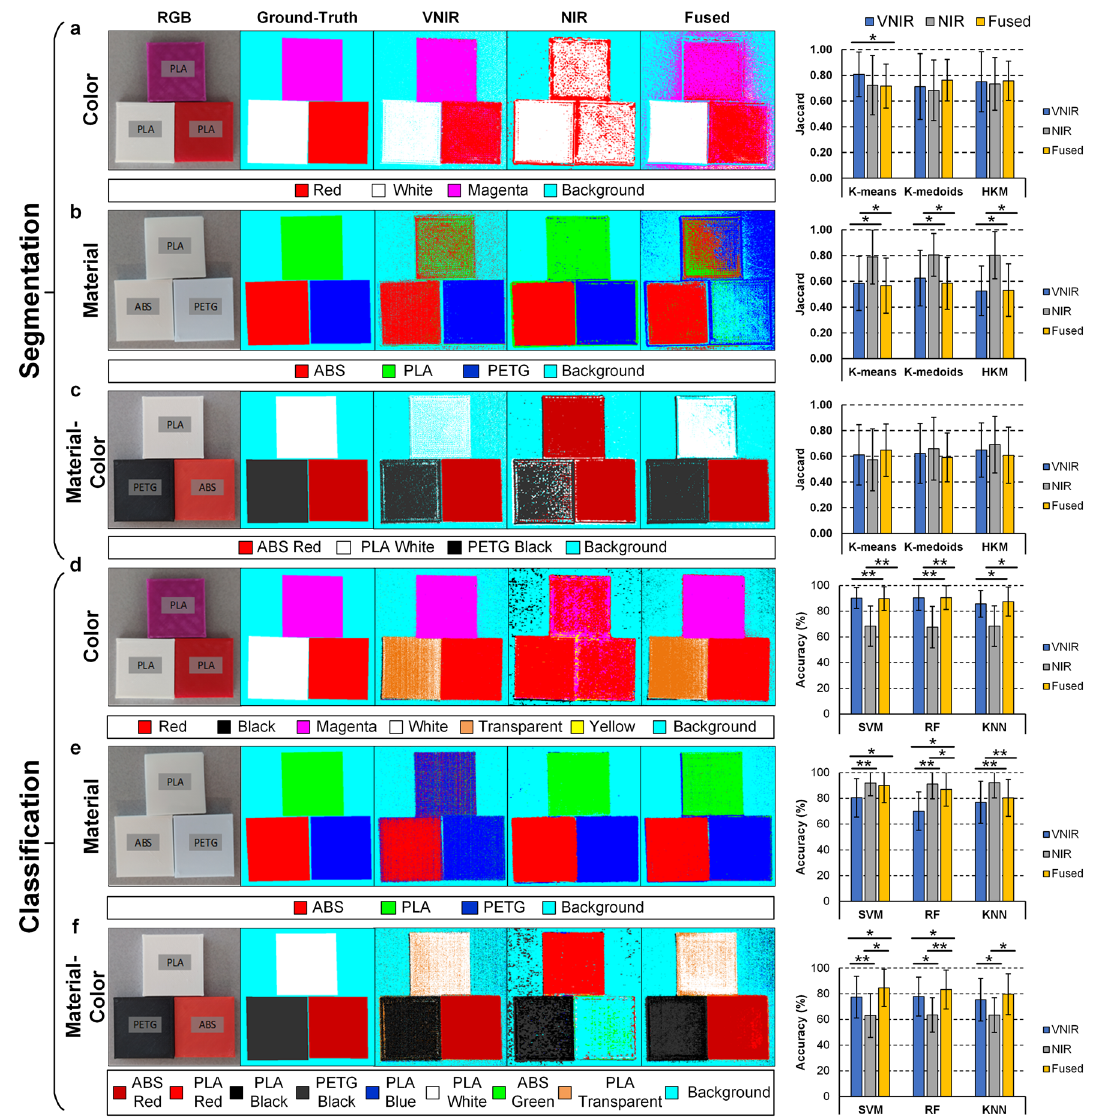
Figure 3. Segmentation and classification maps of three examples of the test set from the HSI plastic dataset and average Jaccard and accuracy results obtained from the thirteen images. Color , material , and material-color segmentation ( a – c ) and classification ( d – f ) problems, respectively, using VNIR, NIR, and fused data. Each column (from left to right) represents the RGB images obtained with a digital camera, the ground-truth maps, the VNIR, NIR, and fused segmentation results, respectively, and the average Jaccard and accuracy results obtained with the entire test set for the three different segmentation and classification algorithms. Results were statistically analyzed using a paired, one-tailed Student’s t test at the 5% significance level. (*) Statistically significant difference ( p < 0.05 ). (**) Highly statistically significant difference ( p < 0.001 ) . ABS: Acrylonitrile Butadiene Styrene; PLA: Polylactic Acid; PETG: Polyethylene Terephthalate Glycol. HKM: Hierarchical K-means; SVM: Support Vector Machines; RF: Random Forest; KNN: K-Nearest ground-truth image and the segmentation map of each HS image. As expected, the VNIR data achieved the highest results in the color segmentation using K-means algorithm, followed by the Fused data using K-medoids and hierarchical K-means (Fig. 3a), while the material identification was superior using the NIR data in all three algorithms (Fig. 3b). However, the material-color segmentation of the NIR data using hierarchical K-means improved the segmentation results followed by the Fused data using K-means (Fig. 3c). Statistical analysis was performed to the segmentation results using a paired, one-tailed Student’s t -test at 5% significance level. No statistically differences were found between the results of the material-color segmentation problem. Tables S2, S3, and S4 in Supplementary Material details the Jaccard results applying K-means, K-medoids, and hierarchical K-means algorithms, respectively, for each test HS image and the average and standard deviation values. Support Vector Machines (SVMs), Random Forest (RF), and K-Nearest Neighbors (KNN) algorithms were employed for the supervised classification. A coarse-to-fine search (in the case of SVM) and a coarse search (in